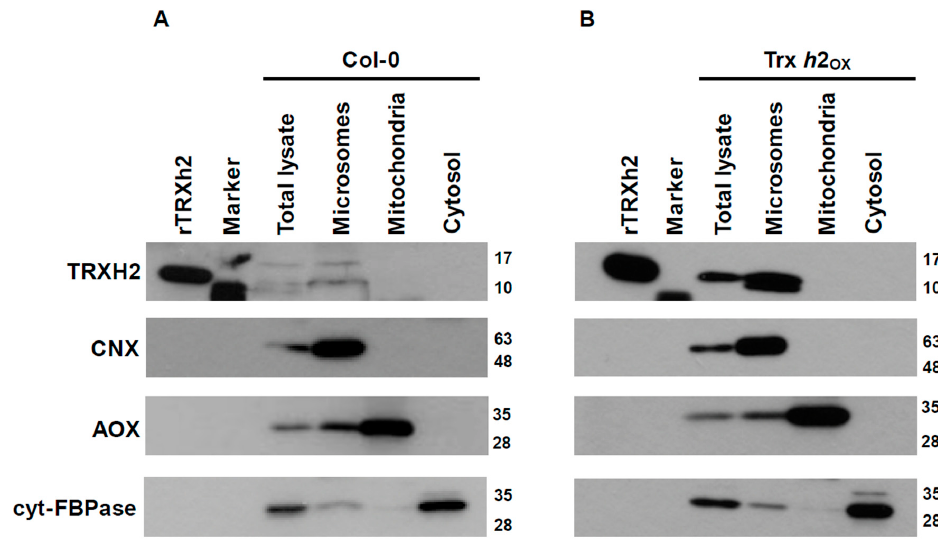
Figure 1. The enrichment of the Trx h 2 protein in different subcellular fractions. The wild-type plants (Col-0) ( A ) and overexpression line (Trx h 2 ox ) ( B ) were grown under medium light condition for two weeks and harvested for sample preparation and cell fractionation. The detection of the TRXH2 protein and other subcellular protein markers was performed via immunoblot analysis. Recombinant Trx h 2 protein (rTRXh2) served as positive control; calnexin (CNX) served as microsomal marker; alternative oxidase (AOX) served as mitochondrial marker; cytosolic fructose-1,6-bisphosphatase (cyt-FBPase) served as cytosolic marker. In the lane labeled “Marker,” marker proteins from the protein ladder were loaded. The numbers next to each blot indicate the molecular weight (kDa) of protein